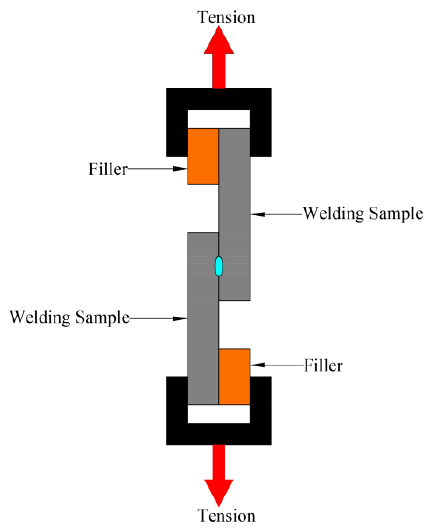
Figure 2. The schematic of the lap shearing test.